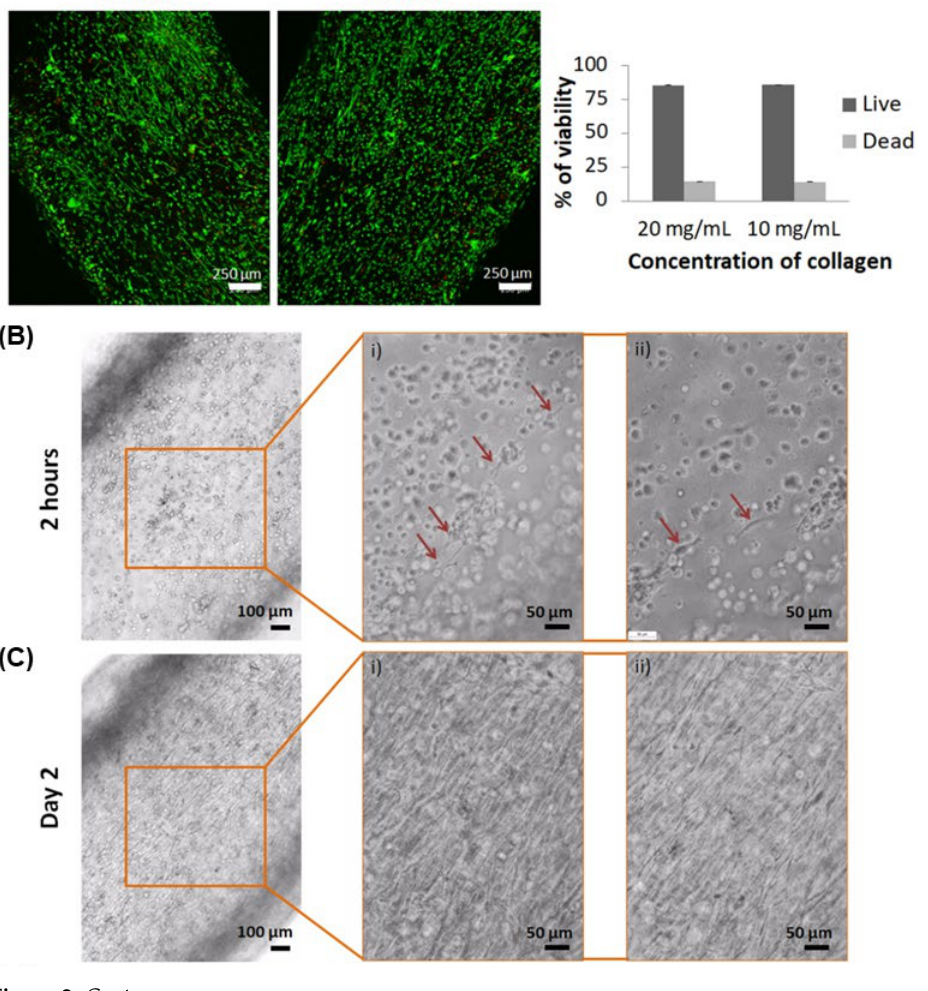
Figure 2. Viability and images of TEBVs with human umbilical vein endothelial cells (HUVEC) and human aortic smooth muscle cells (HASMC) in co-culture. ( A ) Live/dead assay performed on TEBV containing HUVEC and HASMCs in co-culture at 24 h after extrusion (live cells in green and dead cells in red). ( B ) First cells spreading after 2 h of TEBV culture. On the right are presented magnifi- cations at two different plans with red arrows indicating stretched cells. ( C ) Practically all cells were lengthened within 2 days of TEBV culture. On the right are magnifications at two different plans. ( D ) TEBVs started to blend from day 5 at different focus, showing cells on top (i) and cells at the bottom of the TEBV (ii). Images from two different plans.